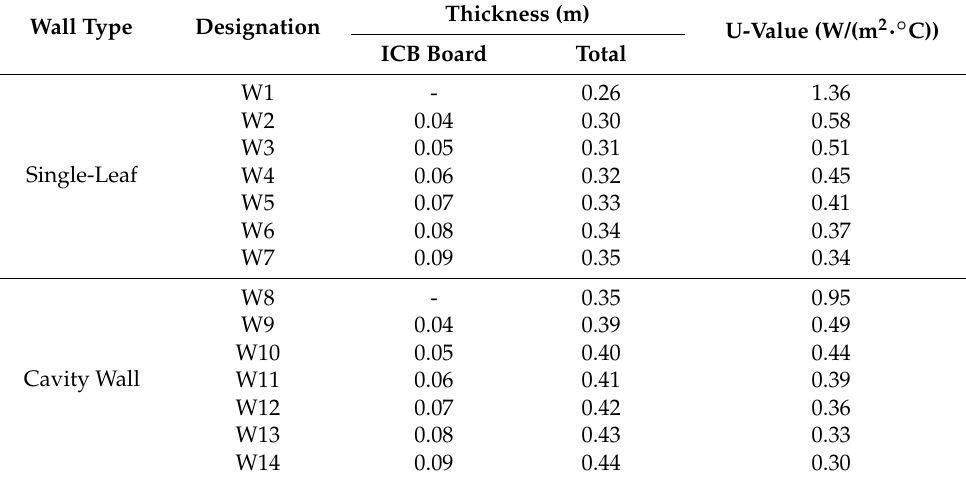
Table 1. Designation, thickness and thermal performance (U-Value) of the ETICS